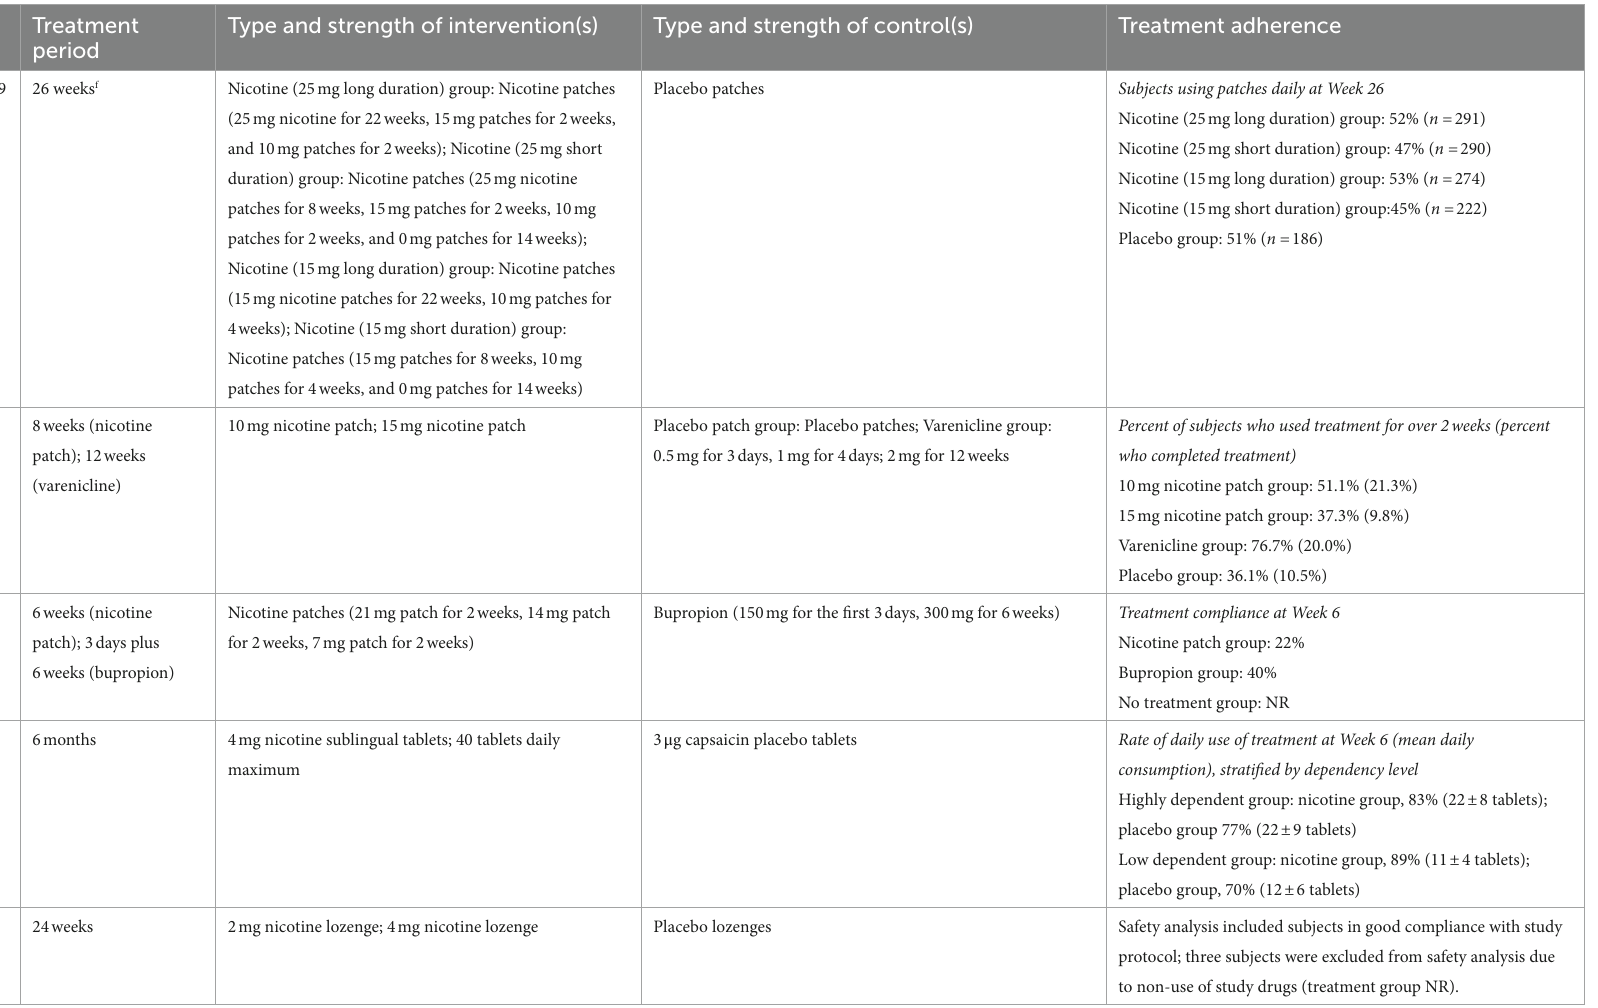
Safety analysis included subjects in good compliance with study protocol; three subjects were excluded from safety analysis due to non-use of study drugs (treatment group